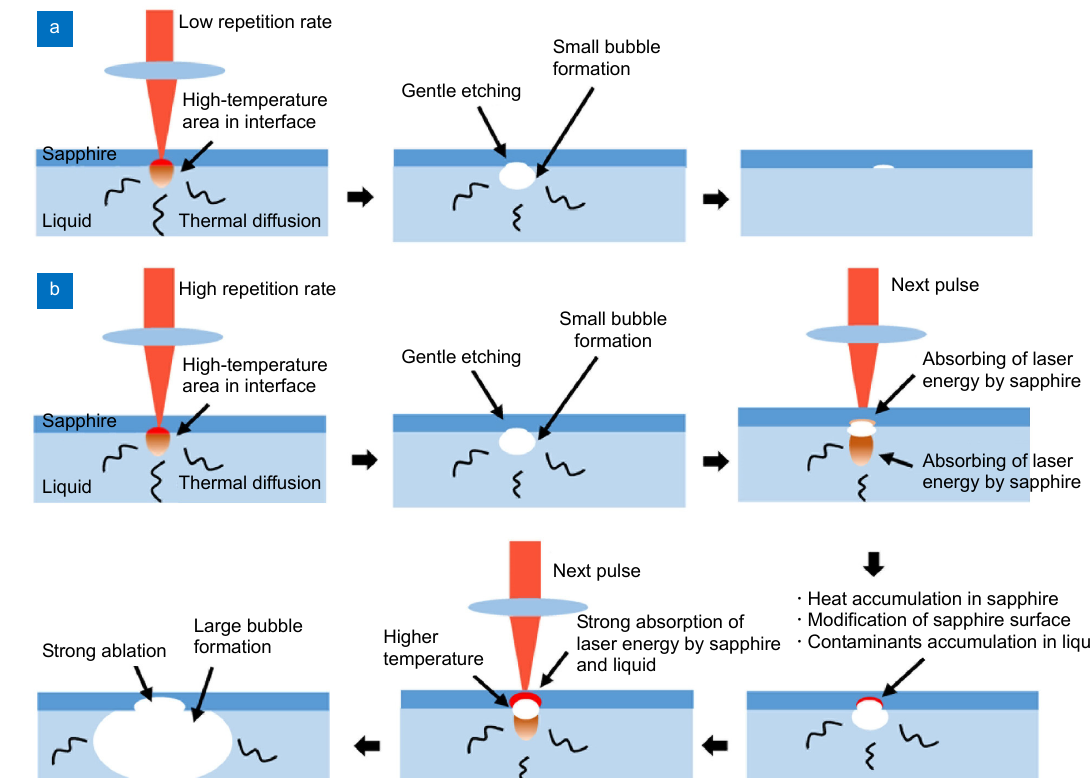
Fig. 8 | Schematic illustration of the LIBWE process using near-infrared laser pulses with ( a ) a low repetition rate and ( b ) a high repetition rate . Figure reprinted with permission from ref. 67 , Elsevier